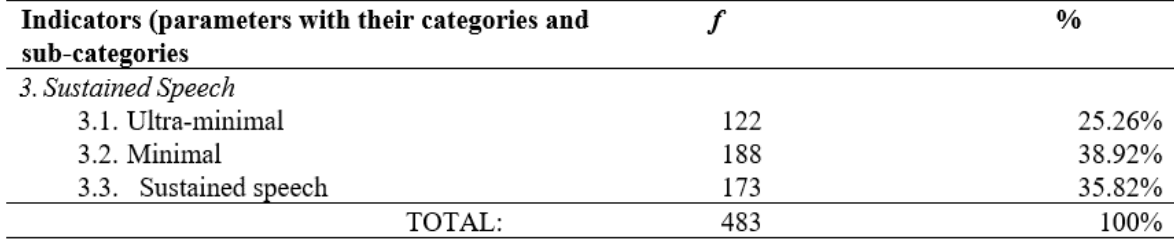
Table 4. Sustained Speech as a Communicative Feature in English Language